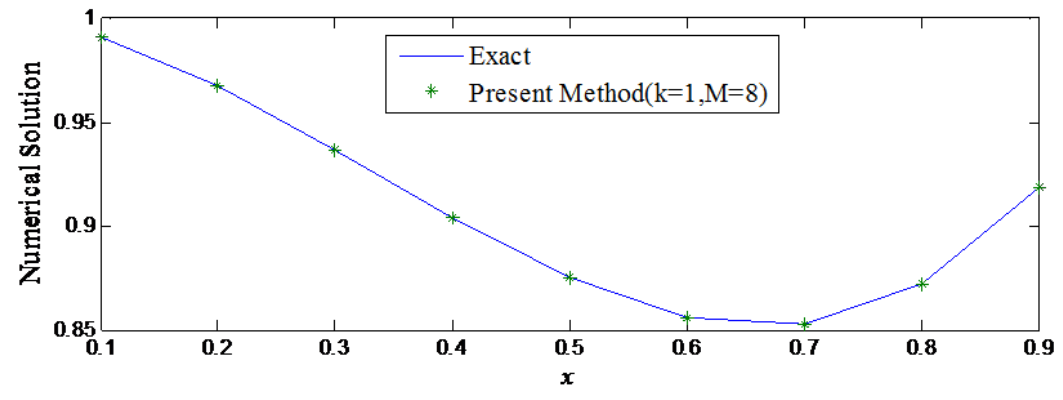
Fig. 1 Comparison of numerical solutions with exact solutions of example 1.